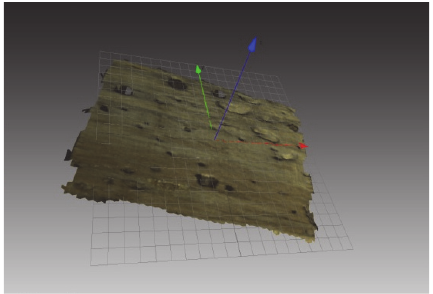
Figure 2: Scanned wood surface in the Artec Studio